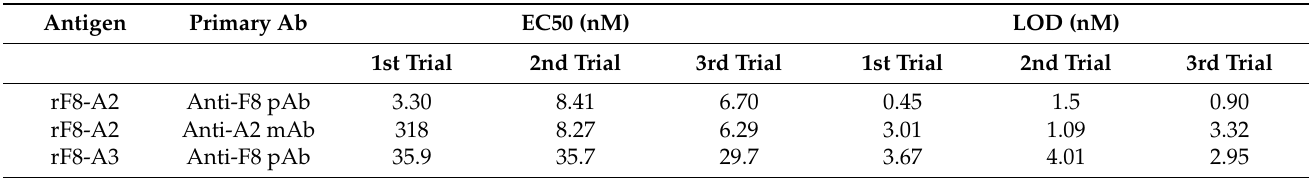
Table 2. EC50 and LOD values from the titration